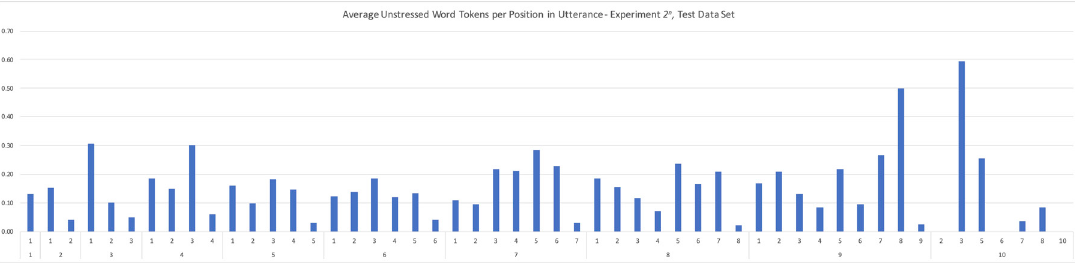
Figure 9: Distribution of Unstressed word tokens as a function of the position of the word in the